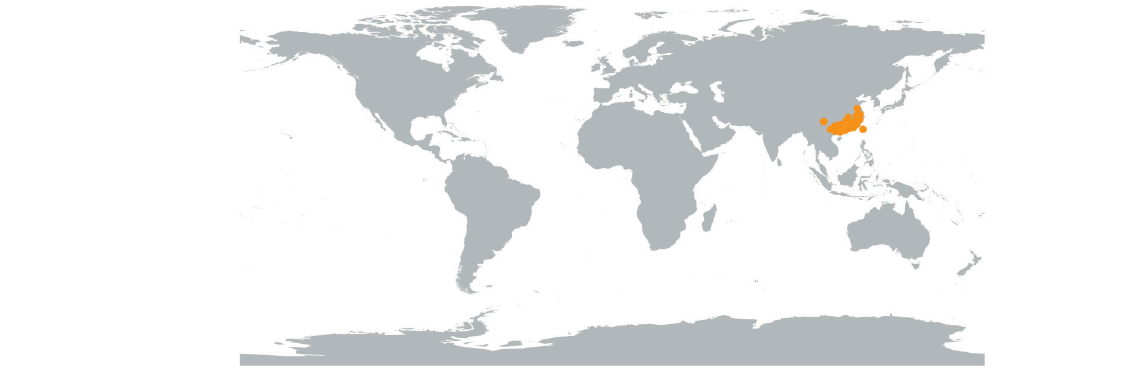
Fig. 57. Distribution of Malus doumeri (Bois)